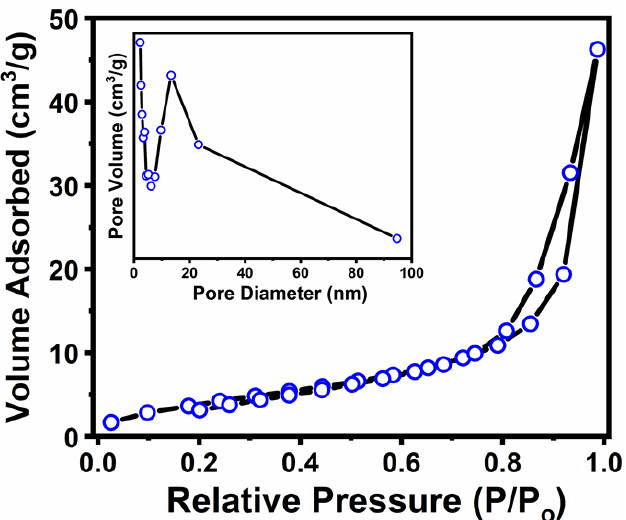
Figure 6. BET isotherms and inset corresponding to BJH pore-size distribution curves for the calcined Ni-CoWO 4 NPs.